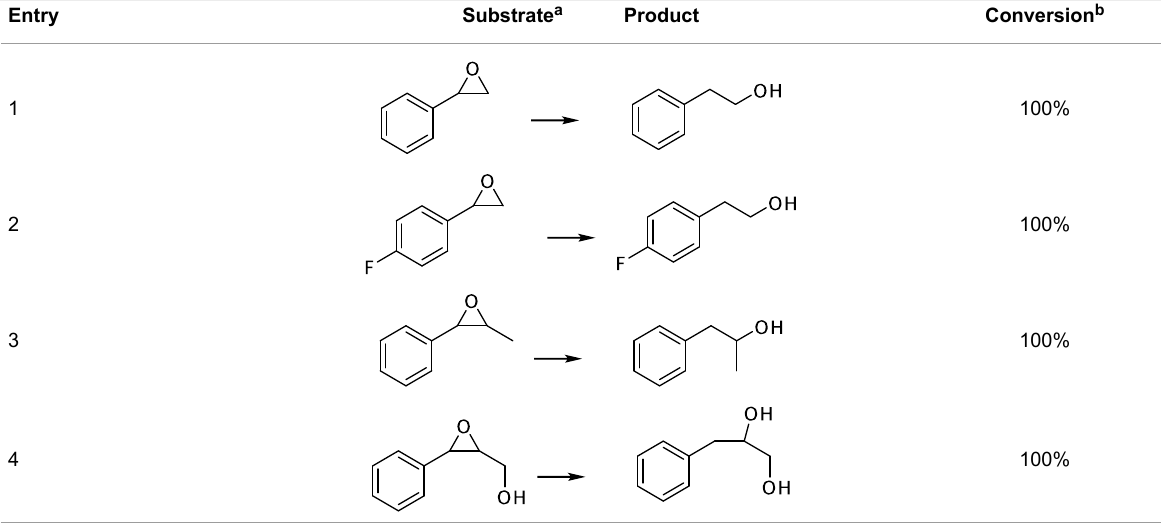
Table 4: Pd(0)EnCat™30NP-catalyzed hydrogenolysis of aryl epoxides.